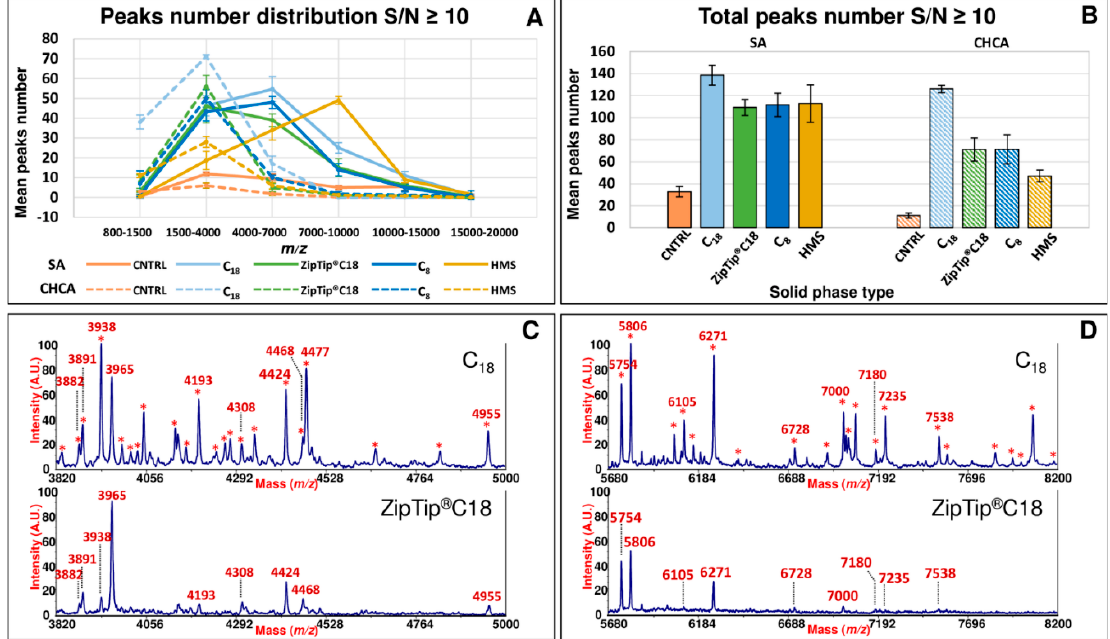
Figure 3. MALDI-TOF peaks number distribution using different d -SPE sorbents and peptides enrichment comparison between C 18 d -SPE and ZipTip ® C18. Panel ( A ) shows the mean peaks number distribution for SP samples over different m / z ranges using SA and CHCA before and after processing by C 18 , ZipTip ® C18, C 8 and HMS. Panel ( B ) displays the total peaks number detected for SP samples using SA and CHCA before and after processing by C 18 , ZipTip ® C18, C 8 , and HMS. Panels ( C , D ) display the comparison of spectral portraits in SA of SP between C 18 and ZipTip ® C18 in the m / z range from 3820 to 5000 and from 5680 to 8200, respectively. Asterisks indicate peaks selectively extracted by C 18 sorbent, which are absent or detected with a lower signal intensity in ZipTip ® C18 treated sample.